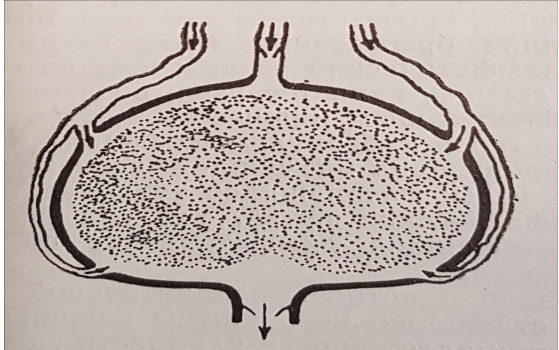
Figure 2. Schematic view of a lymph node with afferent and efferent lymphatics (from